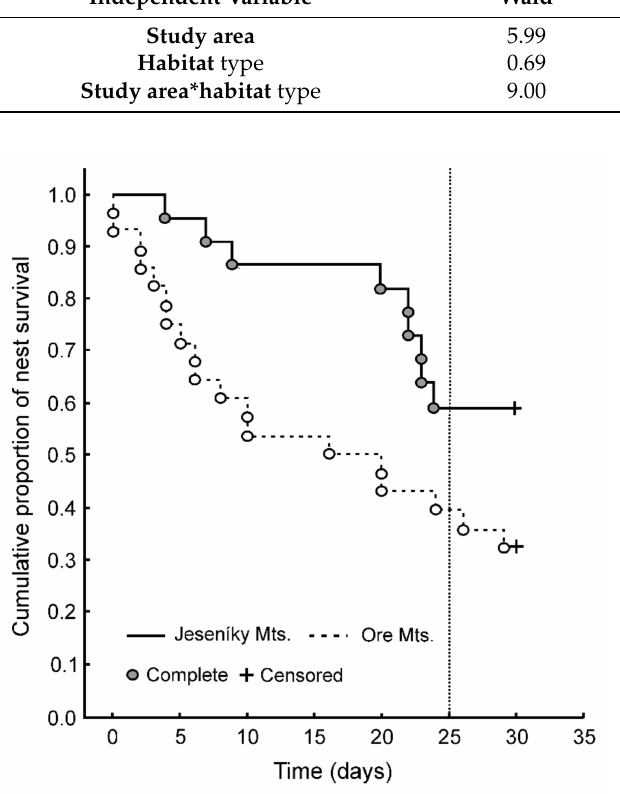
Figure 1. Cumulative proportion of nest survival in Jesen í ky and Ore Mts. during the study period. The dashed vertical line at 25 days (incubation time) shows different survival rate for Jesen í ky Mts. (0.59) and Ore Mts. (0.32). Kaplan–Meier method was used to fit the curves. Complete (predated) and censored (non-predated) nests are